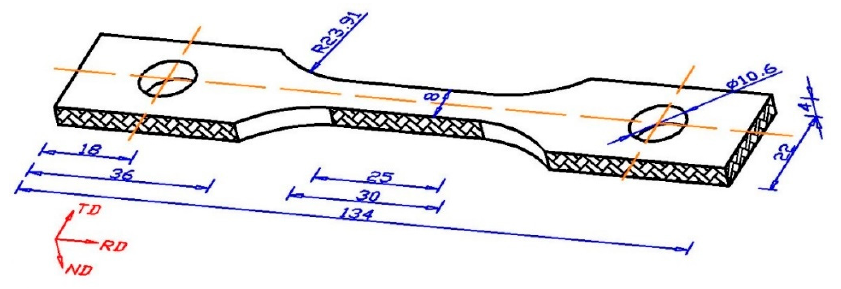
Figure 1. Schematic diagram of samples for tensile and fatigue tests, mm.